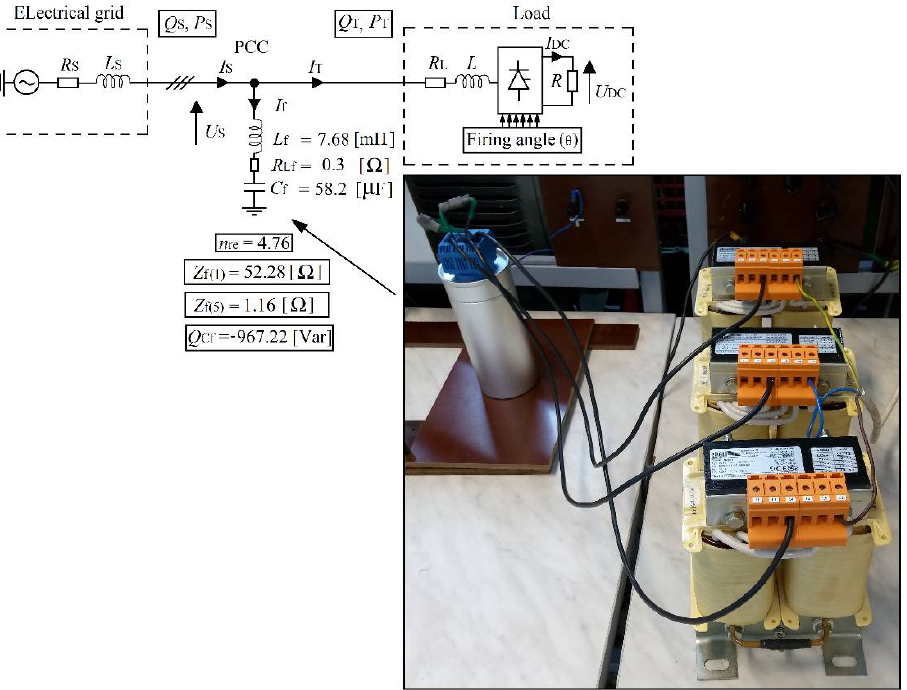
Figure 16. Equivalent circuit of the laboratory model with 5th harmonic single-tuned filter together with the measured parameters. Table 6. Power system parameters measured in the laboratory for different rectifier firing angles (after the filter connection). DPF–displacement power factor; Q S1(1) , Q f1(1), and Q T1(1) are, respectively, the grid, filter, and load fundamental reactive powers. P S1(1) and P f1(1) are, respectively, the grid and filter active powers.